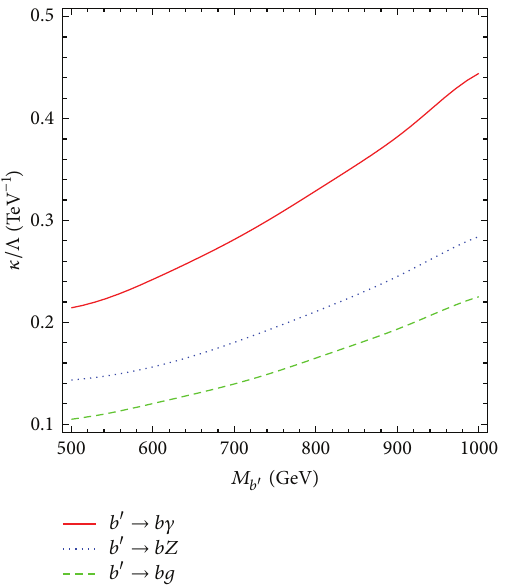
Figure 16: The contour plot of anomalous coupling and mass of new heavy quark 𝑏 󸀠 for the dynamical parametrization explained in the text with a significance of 3𝜎 at √𝑠 = 13 TeV and 𝐿 int = 100 fb −1 .